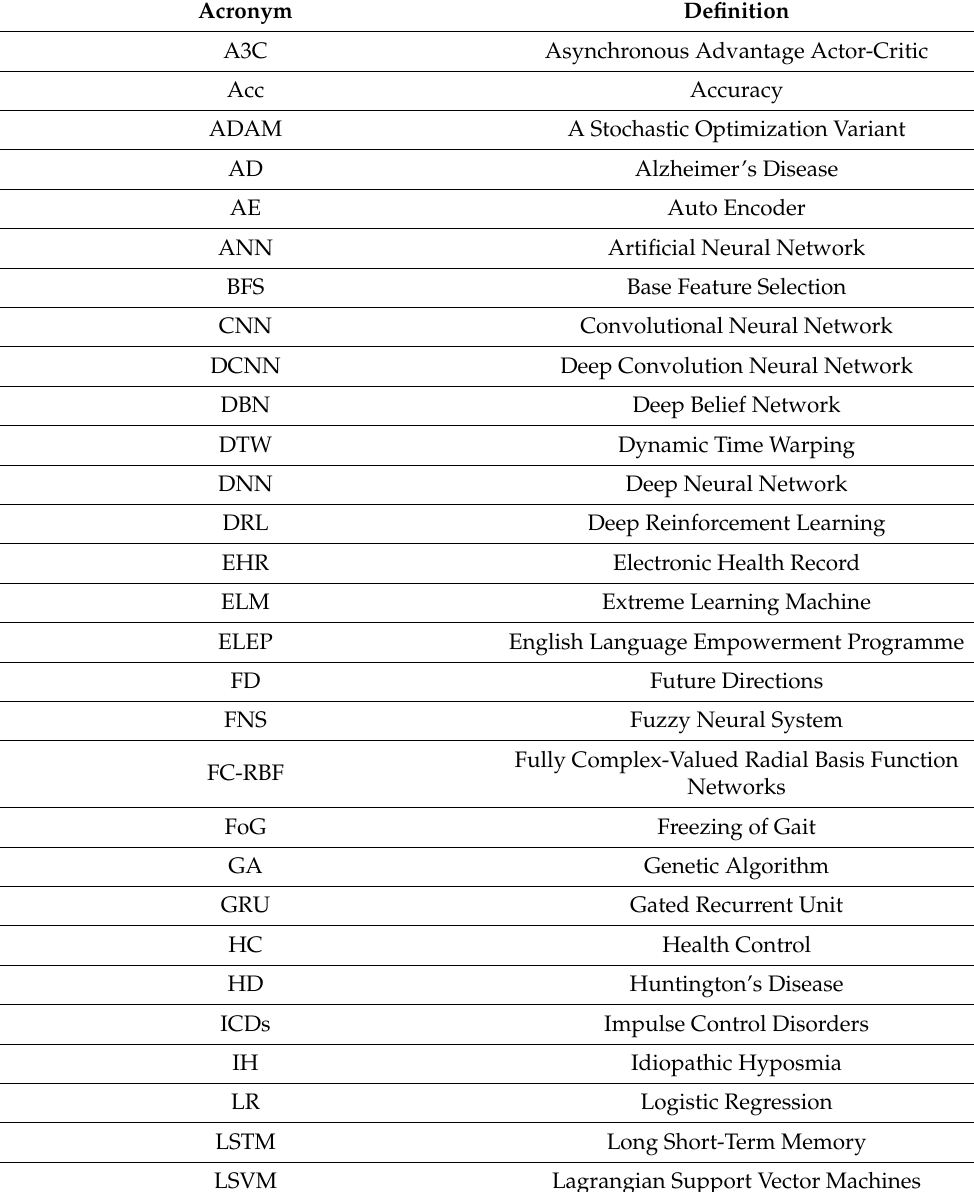
Table 1. List of abbreviations used in this manuscript along with their full